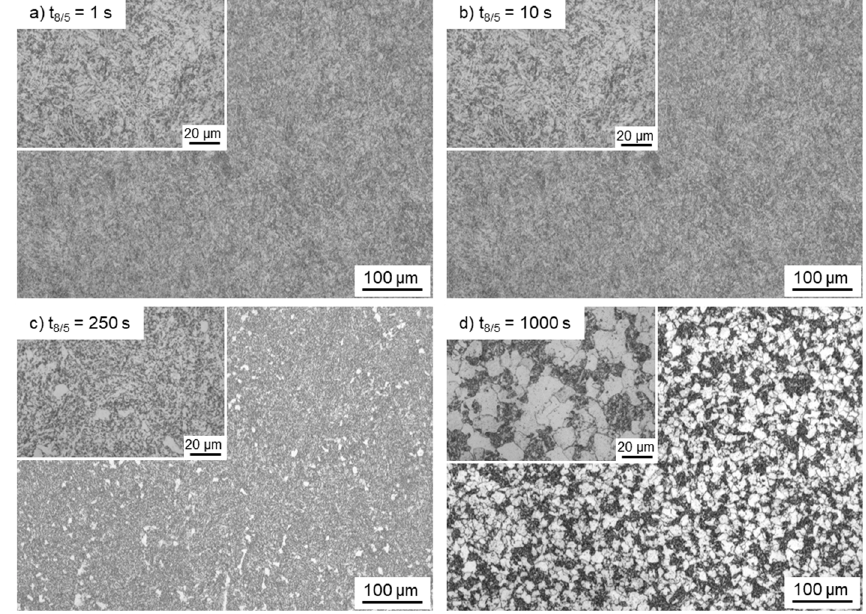
Figure 7. OM images of the microstructure of the dilatometer specimens heated to 1000 ◦ C peak temperature and cooled with di ff erent t 8 / 5 -times of ( a ) 1 s; ( b ) 10 s; ( c ) 250 s; and ( d ) 1000 s at lower and higher